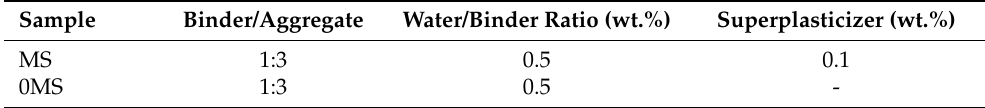
Table 2. Composition of control mortar samples with and without superplasticizer.